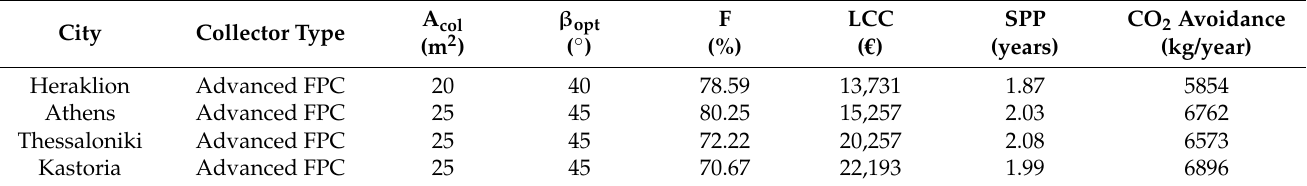
Table 8. Final summary of the optimum designs according to the multi-objective optimization.